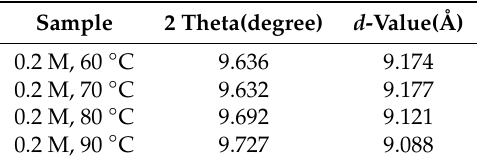
Table 3. Distance calculated by XRD result.